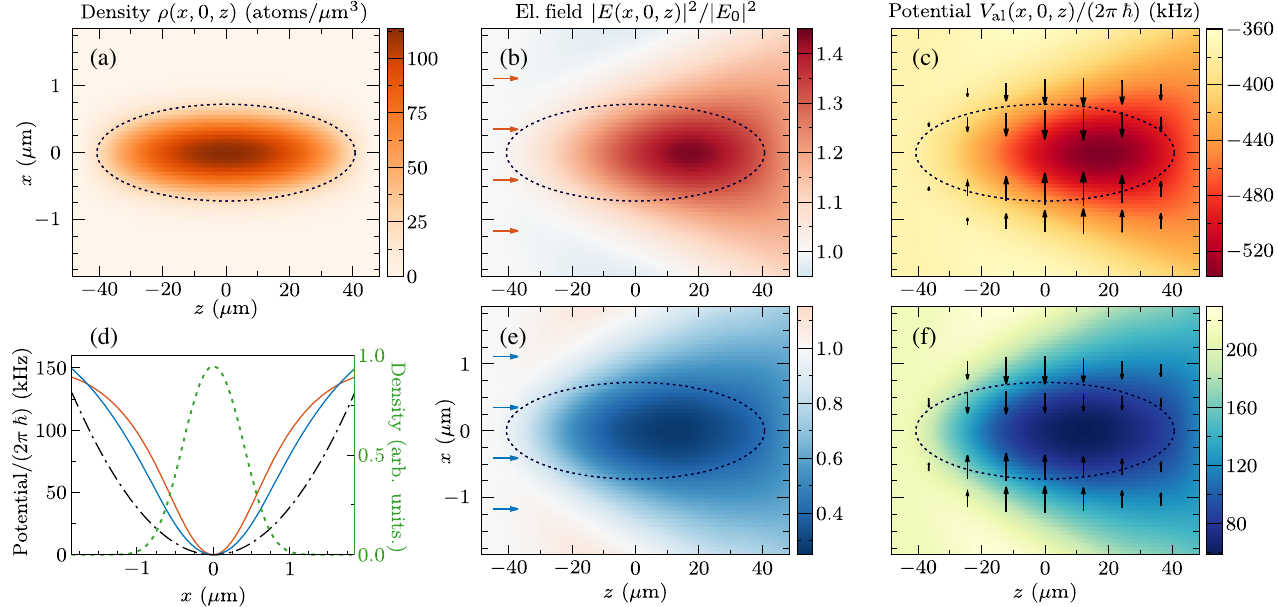
FIG. 2. Simulated interaction between a 1D BEC and red- or blue-detuned light. (a) Density distribution for N ¼ 6200 atoms after an expansion time of 100 μ s. For red-detuned light ( Δ ¼ − 392 Γ ), this corresponds to a peak refractive index of approximately 1.002. For blue-detuned light ( Δ ¼ þ 100 Γ ), the refractive index is reduced to approximately 0.993. The black dotted ellipse indicates where the atom density drops to 10% of its peak value. (b) The macroscopic electric field [solution to Eq. (8)] from the interaction between a red- detuned plane laser wave (traveling from left to right, indicated by arrows) and the cloud of atoms (indicated by the dotted ellipse). We see that atoms act like a focusing lens. (c) Resulting atom-light potential [cf. Eq. (9)]. The saturation is chosen as in Fig. 3 with s ¼ 319 × 10 − 6 . (d) Radial potential at y ¼ z ¼ 0 for red- and blue-detuned cases (red and blue solid line, respectively); the black, dash- dotted curve shows the original radial trapping potential ℏ ω ⊥ x 2 = ð 2 a 2 ⊥ Þ for comparison; the radial atomic density is indicated by the dotted green curve and measured by the right ordinate. The potentials are shifted such that V ð 0 Þ ¼ 0 . Note that the collective atom-light potentials are remarkably strong, comparable to the original magnetic trapping potential, but they have a very different shape. The LIDD self-confining potential shows a depth equivalent to approximately 8 μ K. (e) The same as (b), but for blue-detuned ( Δ ¼ þ 100 Γ ) light. The atoms now act like a divergent lens. (f) The same as (c), atom-light potential for a saturation s ¼ 708 × 10 − 6 and Δ ¼ þ 100 Γ . In both (c) and (f), the highest potential energy corresponds to light interacting with a single atom. The spatial variation of the potential energy causes a compression for red as well as for blue detunings (force indicated by